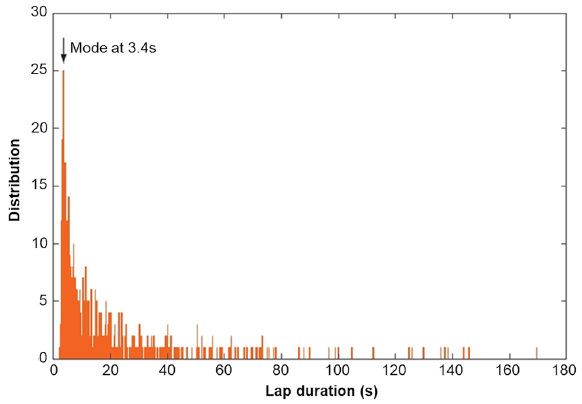
Figure 1. Example of the distribution of lap durations (shape = disc; density = 2.4 g cm −3